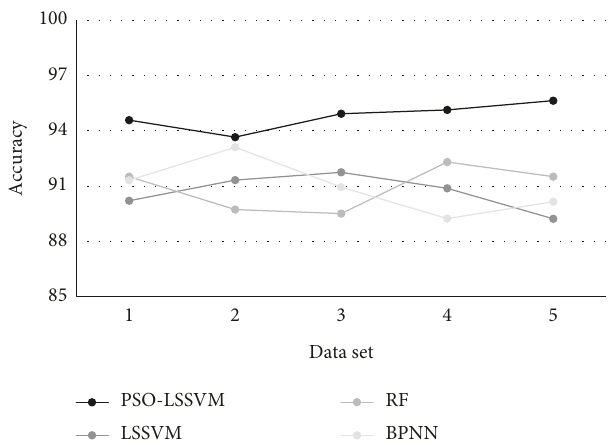
Figure 4: Comparison results of different methods on the test set.